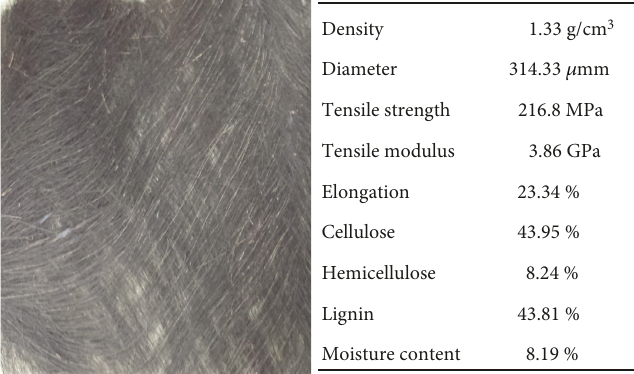
Figure 1: Sugar palm fi bre mat and properties of a single fi bre